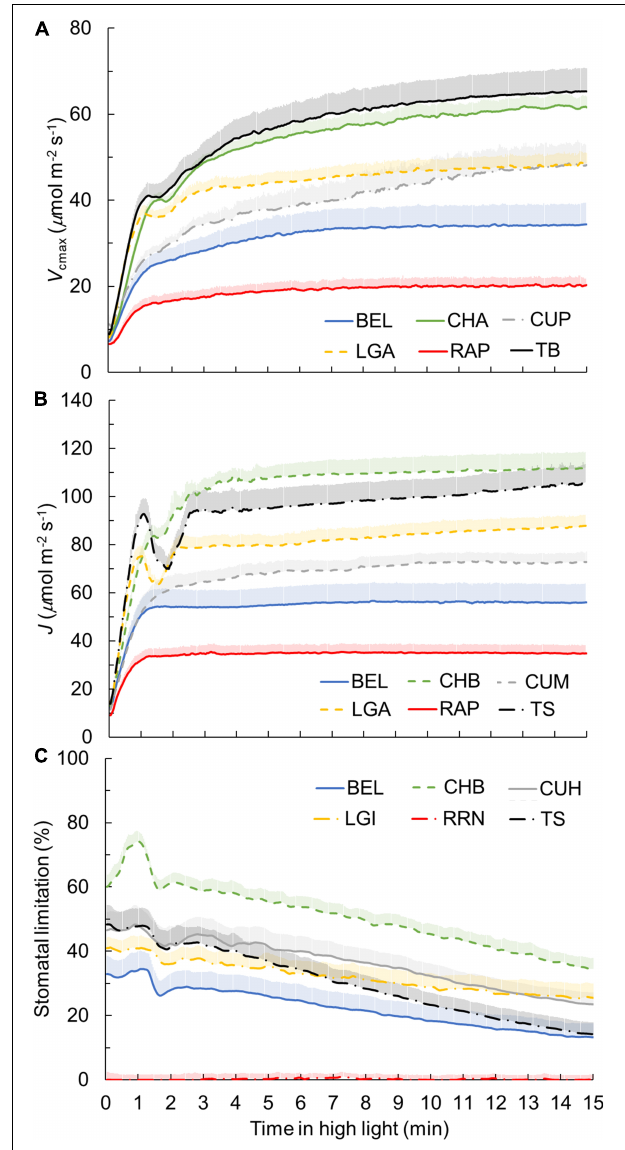
FIGURE 3 | Dynamics of maximum Rubisco carboxylation rate V cmax (A) , electron transport rate J (B) , and stomatal limitations for photosynthesis (C) during photosynthetic induction for six representative genotypes. Each curve represents the mean of 6–7 individual plants (mean + SE). Genotypes showing the smallest and largest value for a given trait among all genotypes, as well as cultivars with an intermediate response for their crop, are shown. Refer to Supplementary Figure 5 for representation of all 19 genotypes, as well as non-stomatal limitations for photosynthesis during photosynthetic